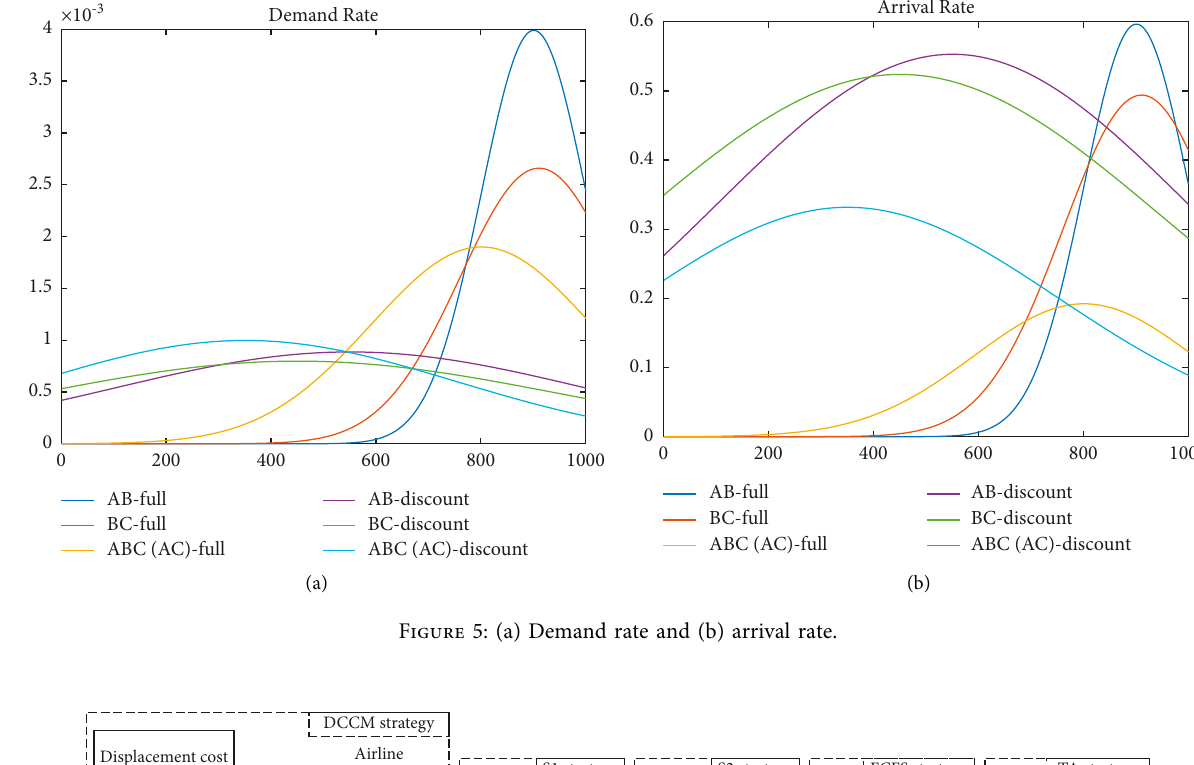
Figure 5: (a) Demand rate and (b) arrival